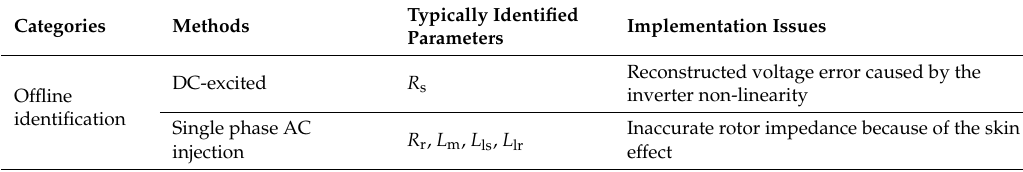
Table 1. A summary of parameter identification methods for